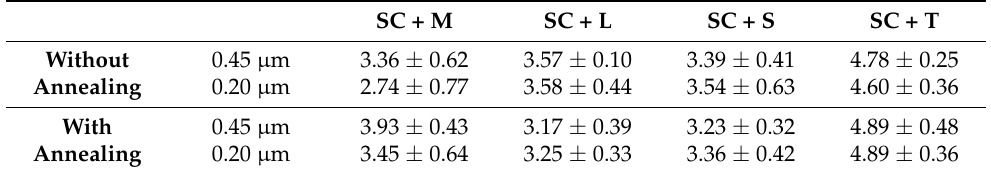
Table 2. Influence of annealing on the remaining moisture (% w / w on a dry product basis) in samples after 24 h of primary drying (SC + M, SC + L, SC + S, and SC + T: sildenafil citrate liposomes with mannitol, lactose, sucrose, and trehalose,